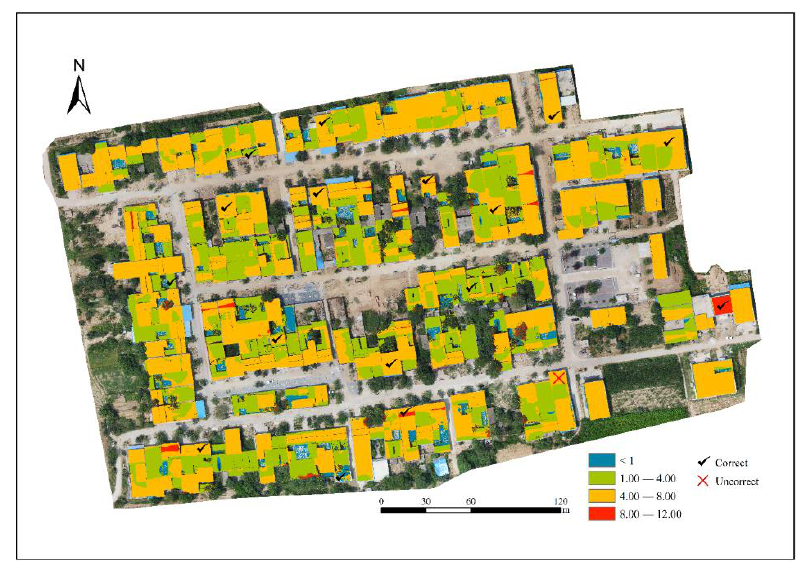
Figure 13. Classification results of building floors with nDSM. Table 5. Confusion matrix for the number of floors divided by the nDSM model.